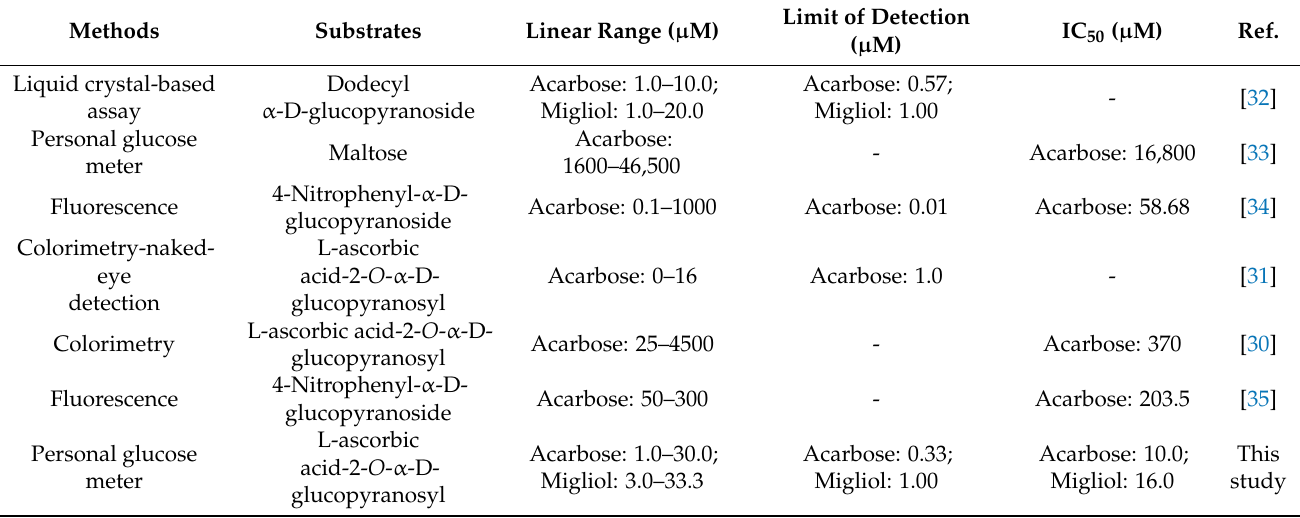
Figure 6. The plots of percentage of inhibition versus the logarithmic concentration of acarbose ( A ) and migliol ( B ) Conditions: α-glucosidase, 314.3 U/mL; incubation time, 5.0 min; AA-2G, 14.0 mM; inhibition time, 3.0 min. Table 1. Comparison of different methods for the anti-diabetic drugs detection in terms of substrates, linear range, limit of detection, and IC 50